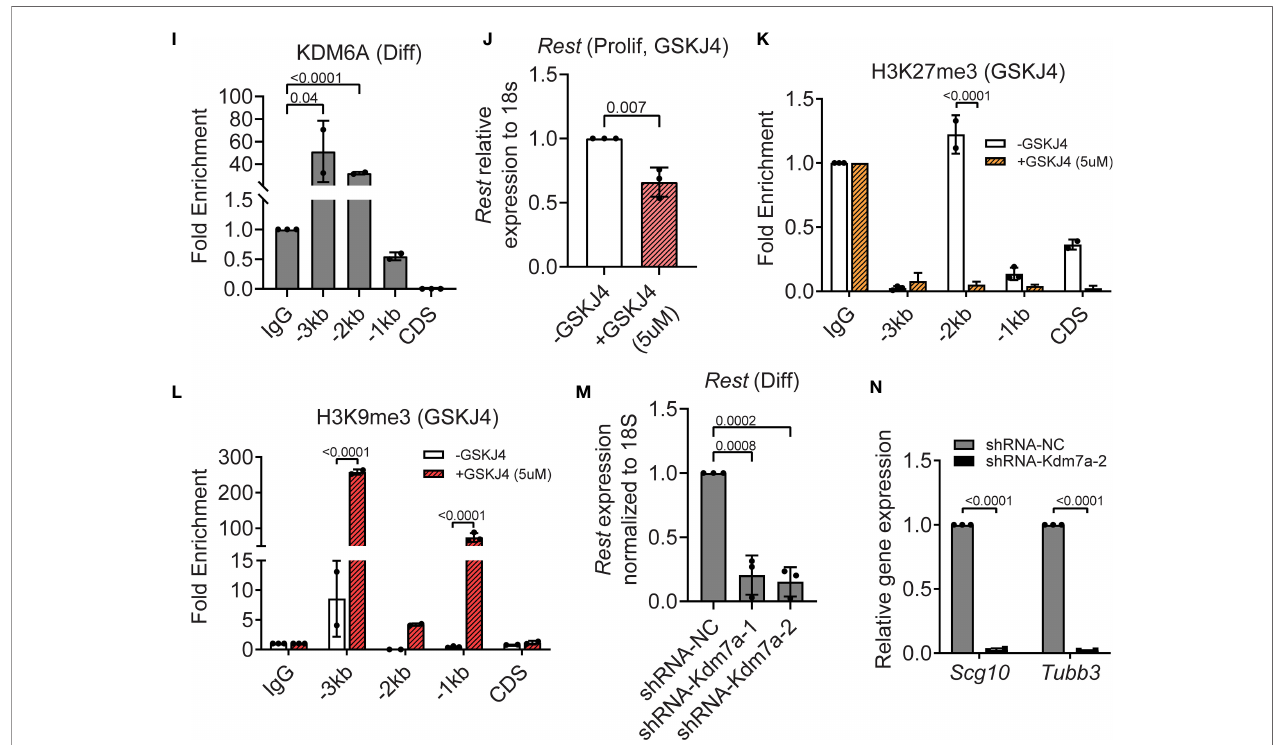
FIGURE 5 | PRC2 and G9A/GLP complexes repress, whereas KDM7A activates REST expression in differentiating progenitors. (A) Enrichment of H3K27me3 over IgG at REST promoter in differentiating (diff) CGNPs measured by ChIP-qPCR. Bars represent fold change of H3K27me3 over IgG in the samples. (B) Enrichment of EZH2 and SUZ12 by ChIP from differentiating progenitors were plotted as fold change over IgG in the samples. (C) H3K9me1, 2 and 3 changes in differentiating progenitors were measured by ChIP-qPCR and represented as fold change over IgG. (D) Enrichment of G9A, GLP, and SUVAR39H1 were measured by ChIP- qPCR and plotted as fold change over IgG. (E) Rest mRNA in differentiating progenitors treated with DMSO, 5 m M UNC-0638, 5 m M Tazemetostat and both drugs were measured by qRT-PCR and normalized to the DMSO controls. (F) Change in enrichment of H3K9me3 comparing DMSO and UNC-0638 + Taze treated progenitors were measured by ChIP-qPCR and plotted normalizing the DMSO control as 1. (G) Differential enrichment of H3K27me3 over IgG was measured by ChIP-qPCR in DMSO and UNC-0638 + Taze treated progenitors and plotted normalizing the DMSO treated control as 1 (n = 3 for DMSO and drug treatment). (H) Change in enrichment of H3K4me3 comparing DMSO and UNC-0638 + Taze treated progenitors were measured by ChIP-qPCR and plotted normalizing the DMSO control as 1. (I) Enrichment of KDM6A at the REST promoter was measured by ChIP-qPCR and represented as fold change over IgG in proliferating and differentiating progenitors. (J) Rest mRNA was measured by qRT-PCR from DMSO and GSKJ4 treated progenitors and plotted normalizing DMSO control as 1 (n = 2). (K, L) Changes in H3K9me3 and H3K27me3 were measured by ChIP-qPCR in DMSO and GSKJ4 treated proliferating progenitors. Graphs were plotted by normalizing DMSO control as 1 (n = 3). (M) Knockdown of Kdm7a using shRNA speci fi c to Kdm7a was performed and Rest transcript was measured 48 hours post shRNA addition (n = 2). (N) mRNA levels of Scg10 and Tubb3 after Kdm7a knock down is shown in differentiating progenitors. For all of the ChIPs shown (unless otherwise speci fi ed) GNPs from 6 mice for differentiating conditions were pooled and the chromatin was isolated followed by